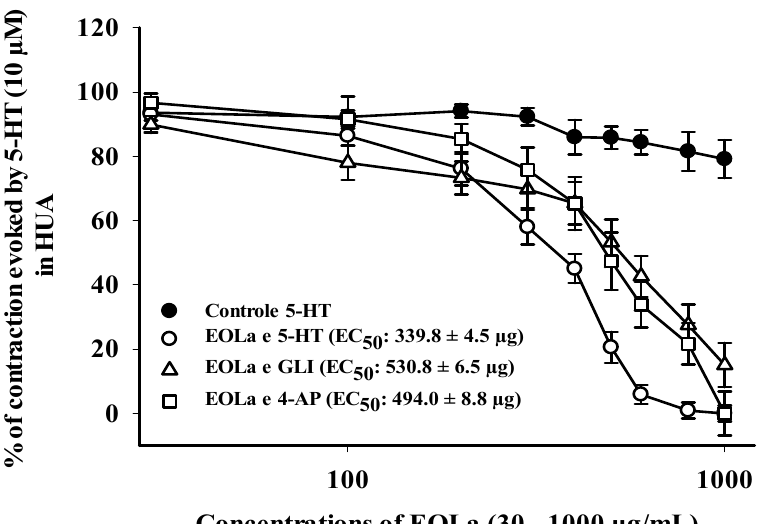
Figure 7. Relaxant effect of EOLa (30–1000 µ g/mL) and evaluation of the participation of voltage-operated K + channels ( Kv) and ATP-sensitive K + channels (K ATP ) in HUA. “Log-normal” plot for the effect of EOLa on stimulated contractions using 5-HT (10 µ M) in HUA rings preincubated with 4-AP (1 mM) or GLI (10 µ M). Values are expressed as the mean ± SEM; n = 6 ( p < 0.05, one-way ANOVA).